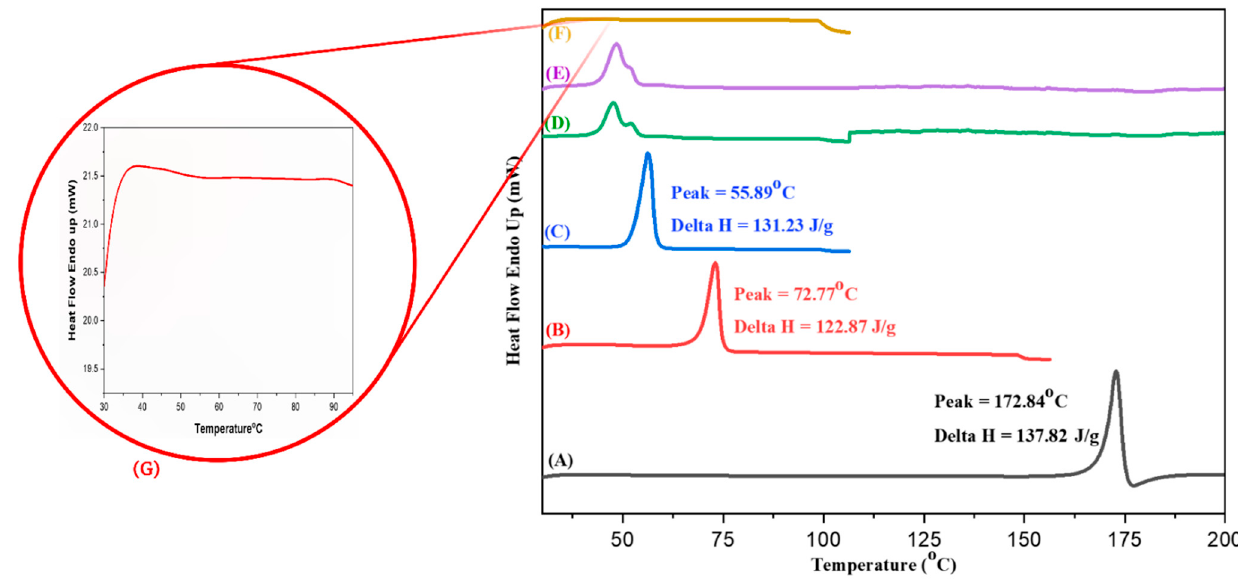
Figure 6. Comparative DSC curves of ( A ) XH, ( B ) CE, ( C ) Pluronic F-68 (PF-68), ( D ) XH-SLNs, ( E ) ( E ) Blank-SLNs and ( F ) LIPOID E 80 SN (LE-80). ( G ) Zoom image of DSC of Blank-SLNs and ( F ) LIPOID E 80 SN (LE-80). ( G ) Zoom image of DSC of LE-80.